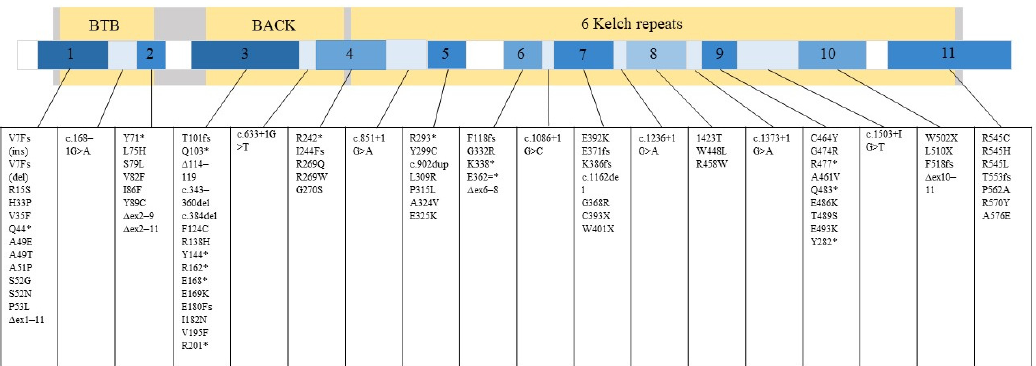
Figure 1. 89 variants associated with GAN that can occur in either exon or intron are listed. Gigaxonin is illustrated by the large grey rectangle and its domains in yellow. The smaller rectangle depicts the GAN gene with its exons numbered 1–11. The relative number of mutations that can occur in different gene regions is represented in a blue gradient. Darker blue equals more mutation. White equals no mutation reported in that region.